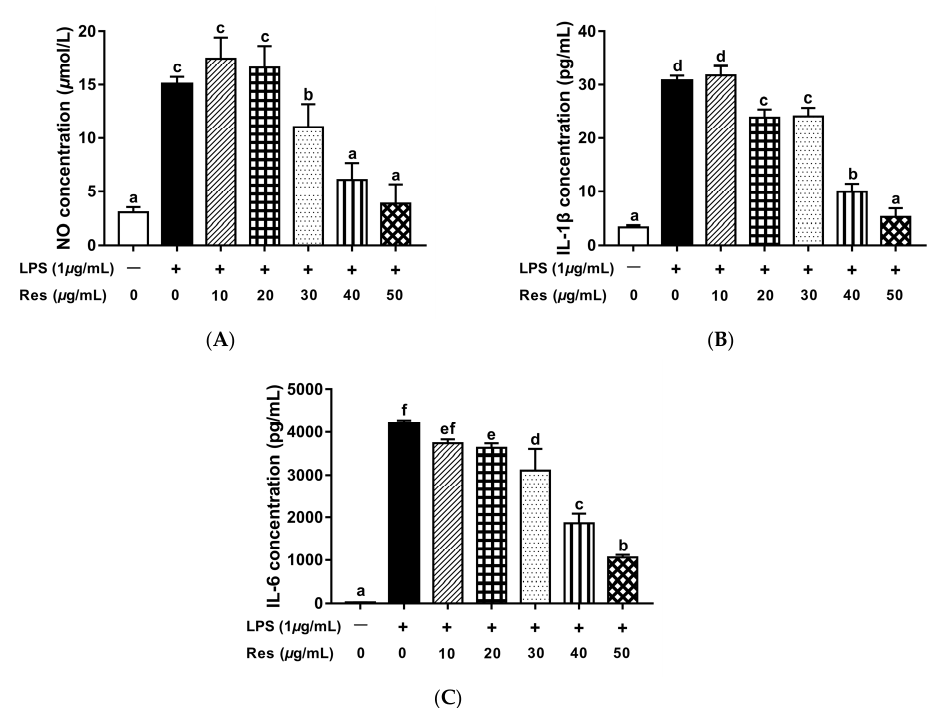
Figure 6. The effect of Res-zein-MSC NPs treatment on the secretion levels of NO ( A ), IL-1 β ( B ) and IL-6 ( C ) in LPS-induced RAW 264.7 cells. Here, different letters represent significant differences ( p < 0.05).